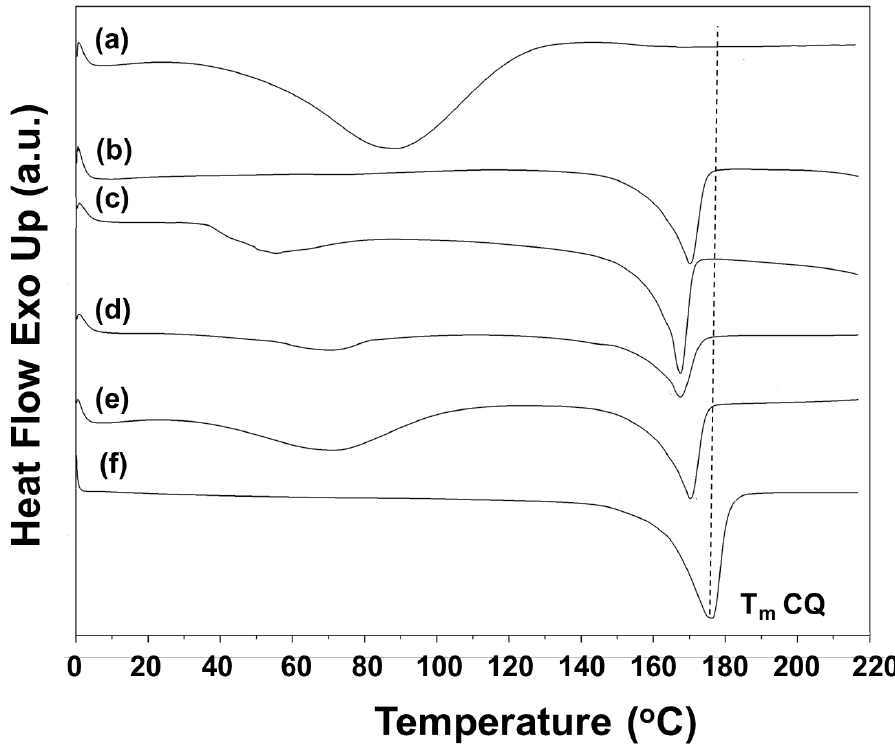
Figure 5. DSC thermograms (first heating run) of ( a ) PVP powder; ( b ) PHB mat; ( c ) PVP in PHB mat; ( d ) PVP,CQ in PHB mat; ( e ) PVP,CQ on PHB mat; and ( f ) CQ powder.